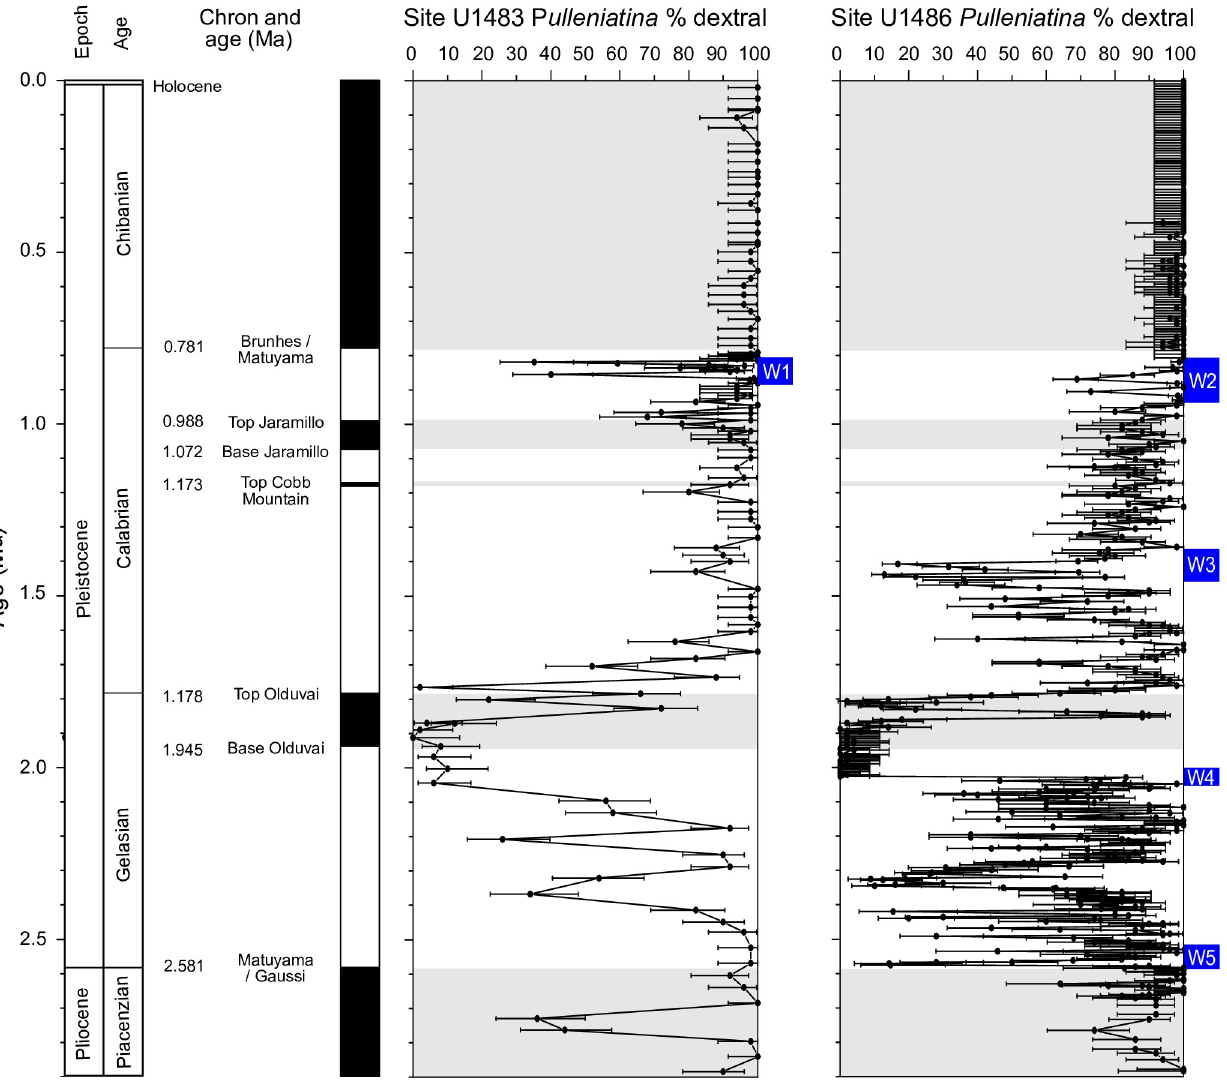
Fig 7. The Pulleniatina coiling records at Indian Ocean Site U1483 and Pacific Ocean Site U1486 compared. Error bars represent 95% confidence intervals. Blue bars represent Windows 1–5 in areas of interest that were chosen for more detailed study. Note that the Brunhes / Matuyama boundary and top of Cobb Mountain normal interval were located only at Site